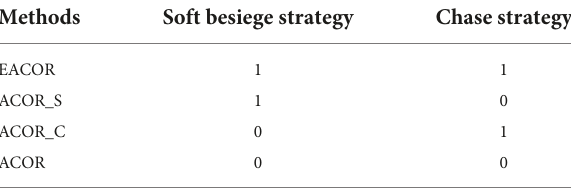
TABLE 3 Four combinations of two strategies in EACOR.